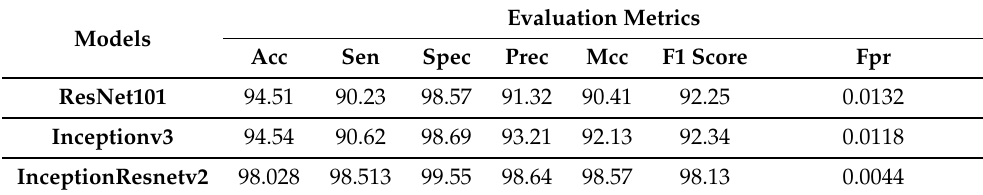
Figure 15. Training progress for InceptionResNetv2 model for dataset #3. Table 9. Results for pre-trained models with image SR using dataset #3.